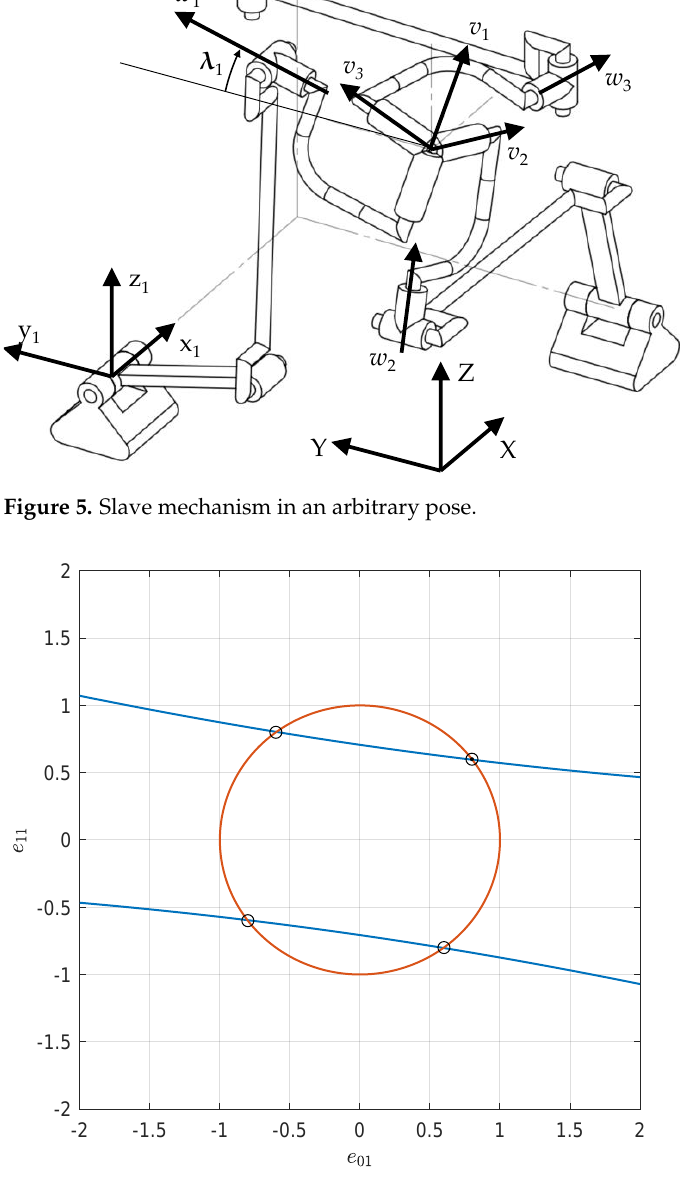
Figure 6. The conics and the circumference in the Euler parameters plane { e 01 , e 11 }